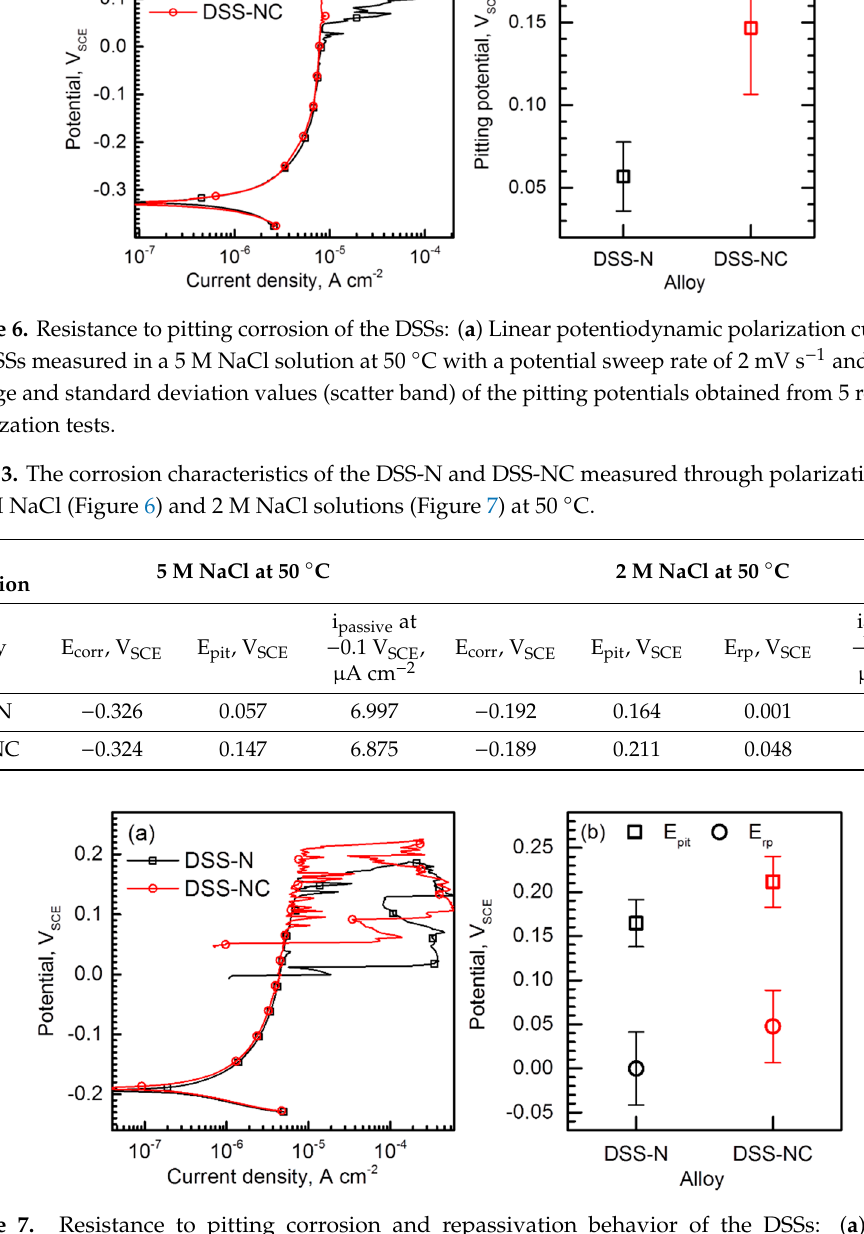
Figure 7. Resistance to pitting corrosion and repassivation behavior of the DSSs: ( a ) Cyclic potentiodynamic polarization curves of the DSSs measured in a 2 M NaCl solution at 50 °C with a potential sweep rate of 2 mV s − 1 and ( b ) the average and standard deviation values (scatter band) of the pitting and repassivation potentials (E pit and E rp , respectively) obtained from five repeated polarization tests. Table 3. The corrosion characteristics of the DSS-N and DSS-NC measured through polarization